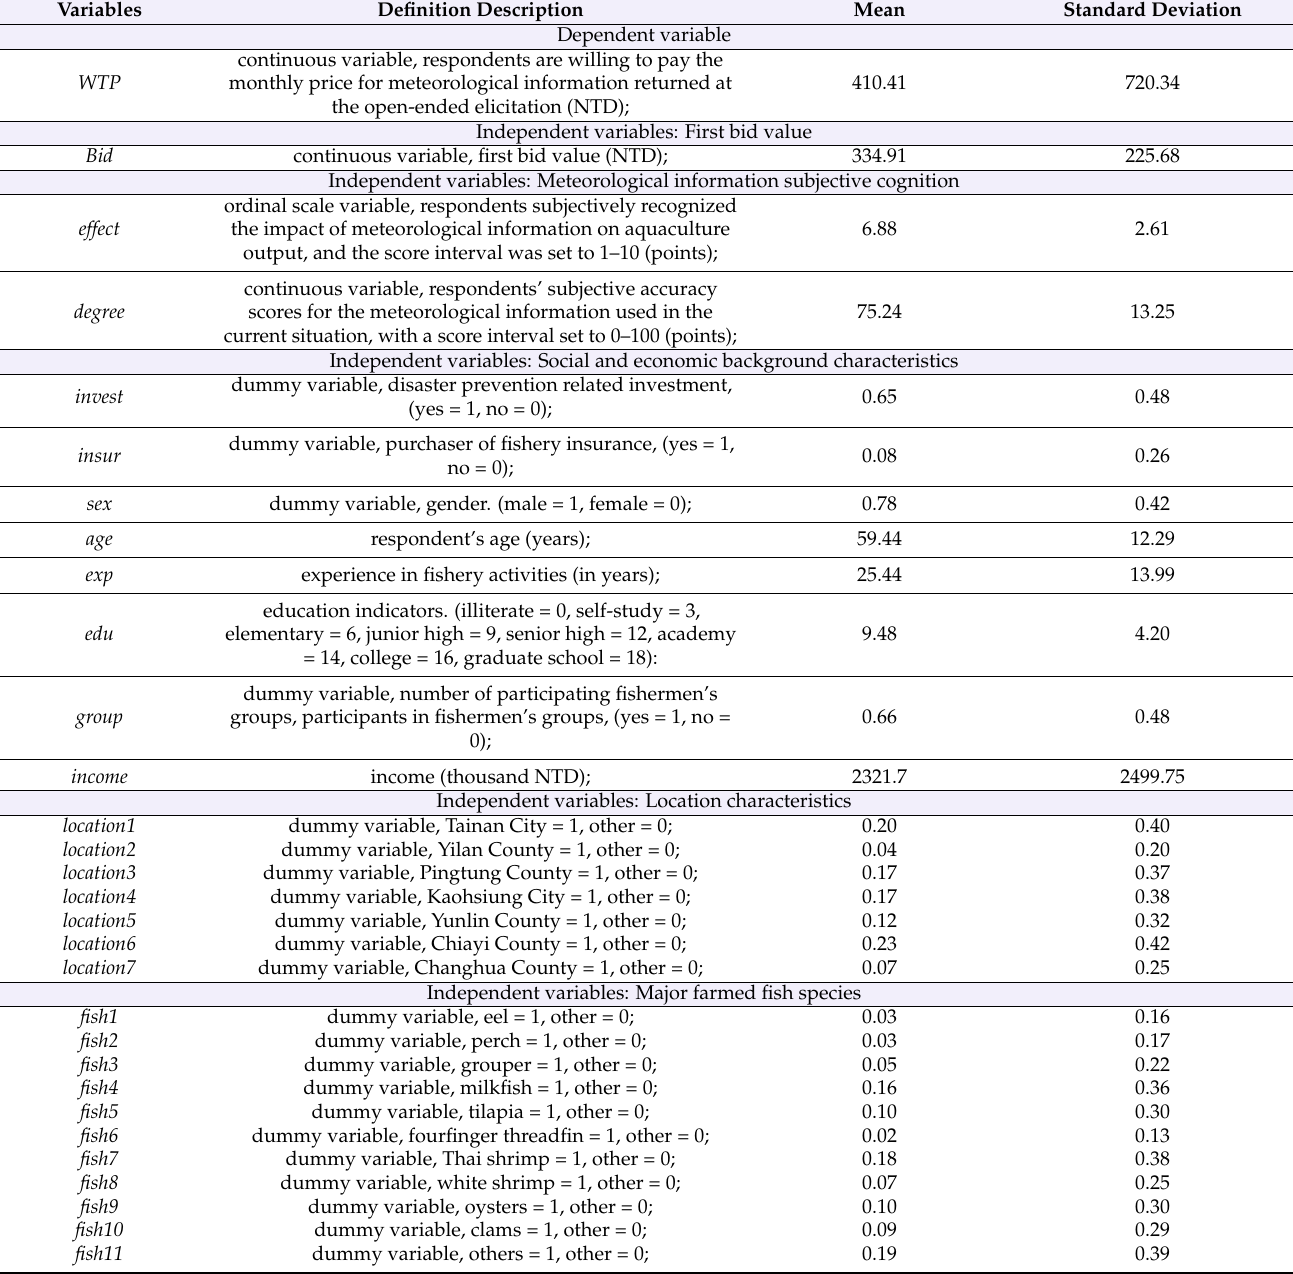
Table 3. Definitions of empirical variables of the meteorological information bidding function for aquaculture